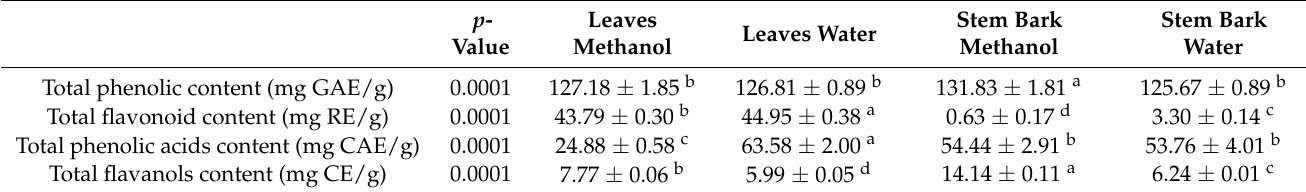
Stem Bark Methanol